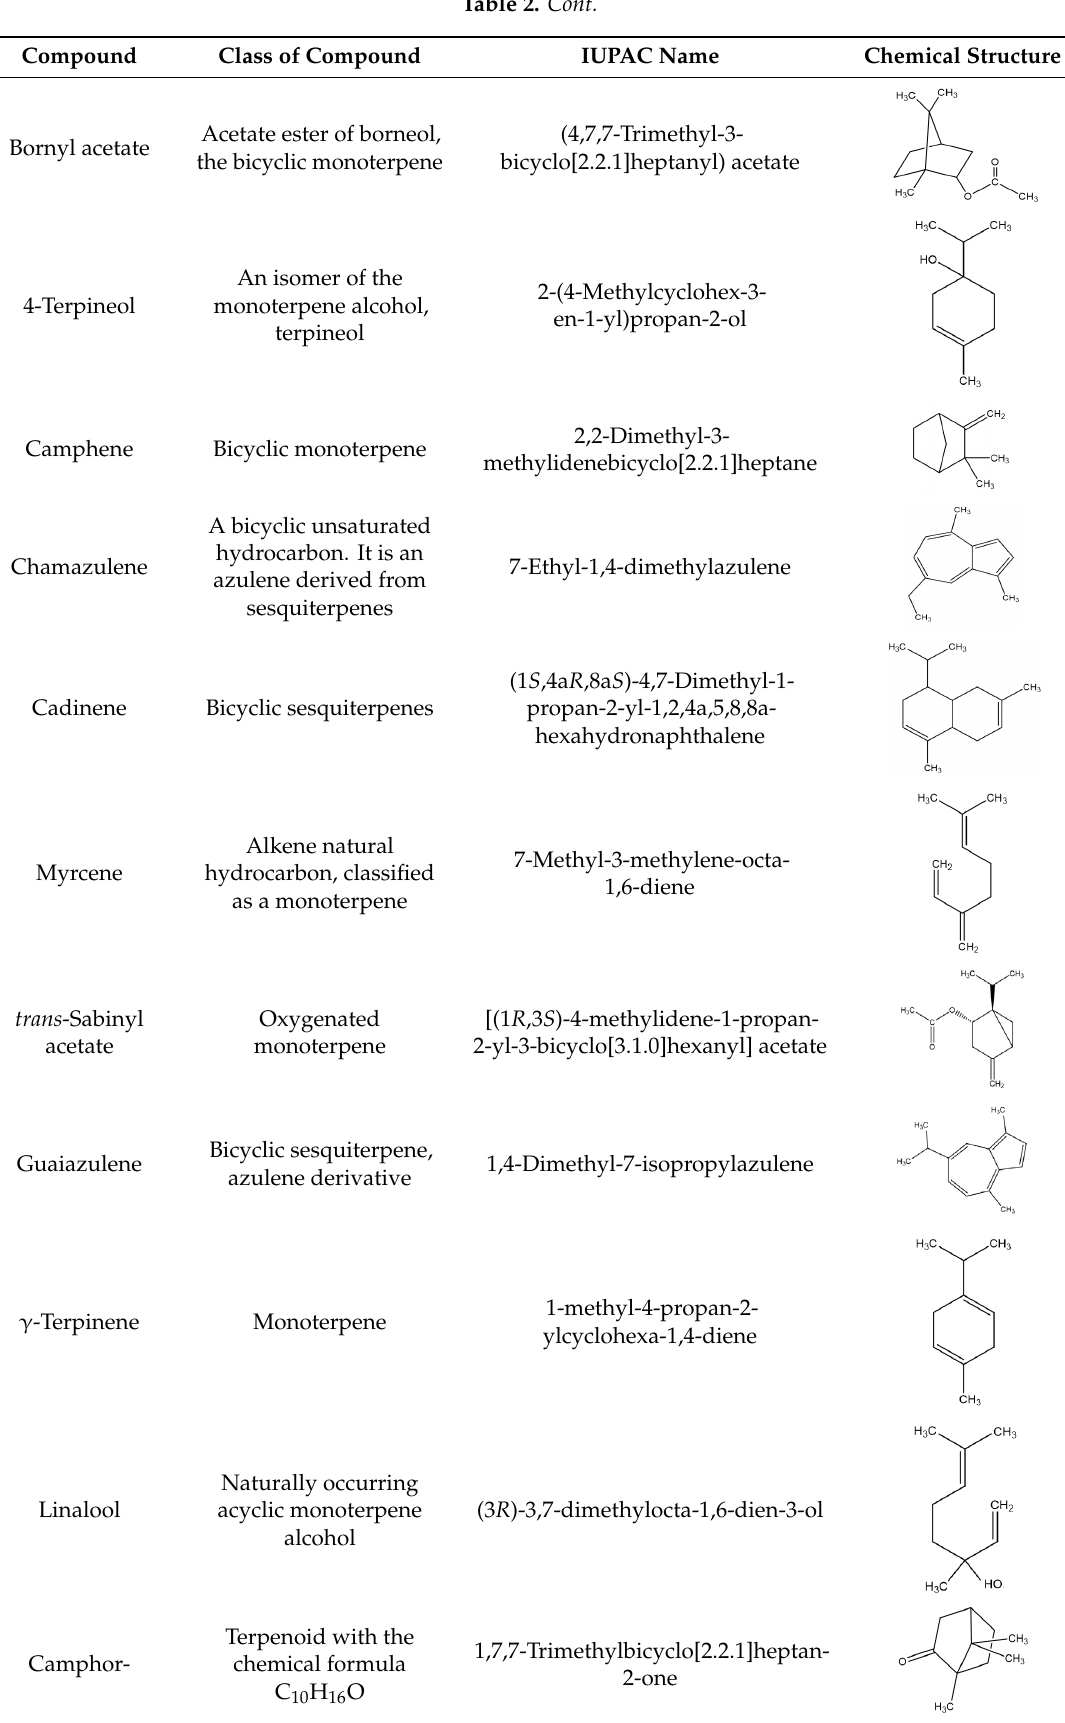
Table 3. Traditional uses of A. absinthium . Geographical Location